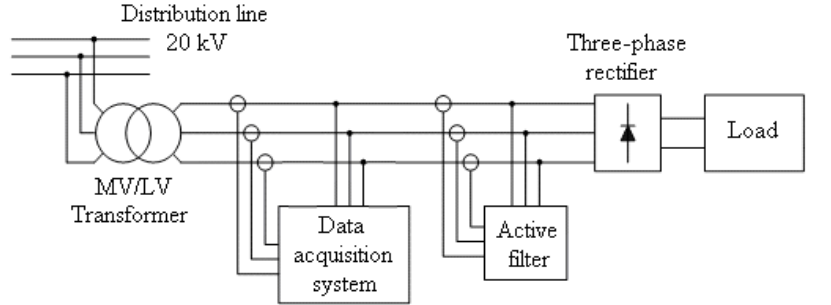
Figure 7. Simplified schematic with the data acquisition system the active filter, three-phase, Rectifier, and load (chopper + D.C. motor + asynchronous generator).